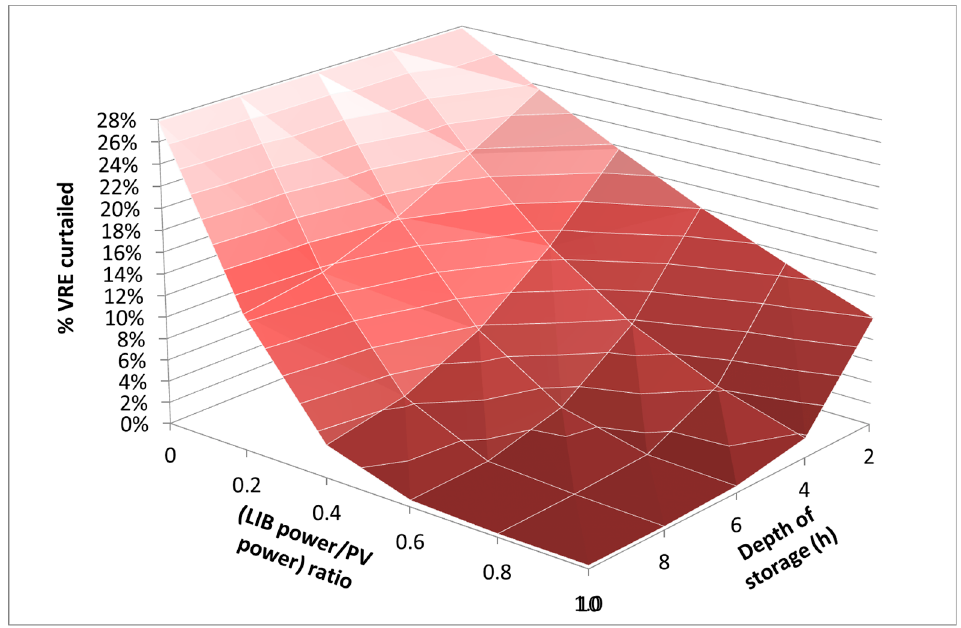
Figure 4. Parametric investigation of variable renewable energy (VRE) curtailment accounting for combinations of lithium ‐ ion battery (LIB) power capacities per PV power and depth of storage (h) in California in the year 2030. Table 1. Key California ISO (CAISO) grid mix parameters for years 2018 (historical data) and 2030 (projected).